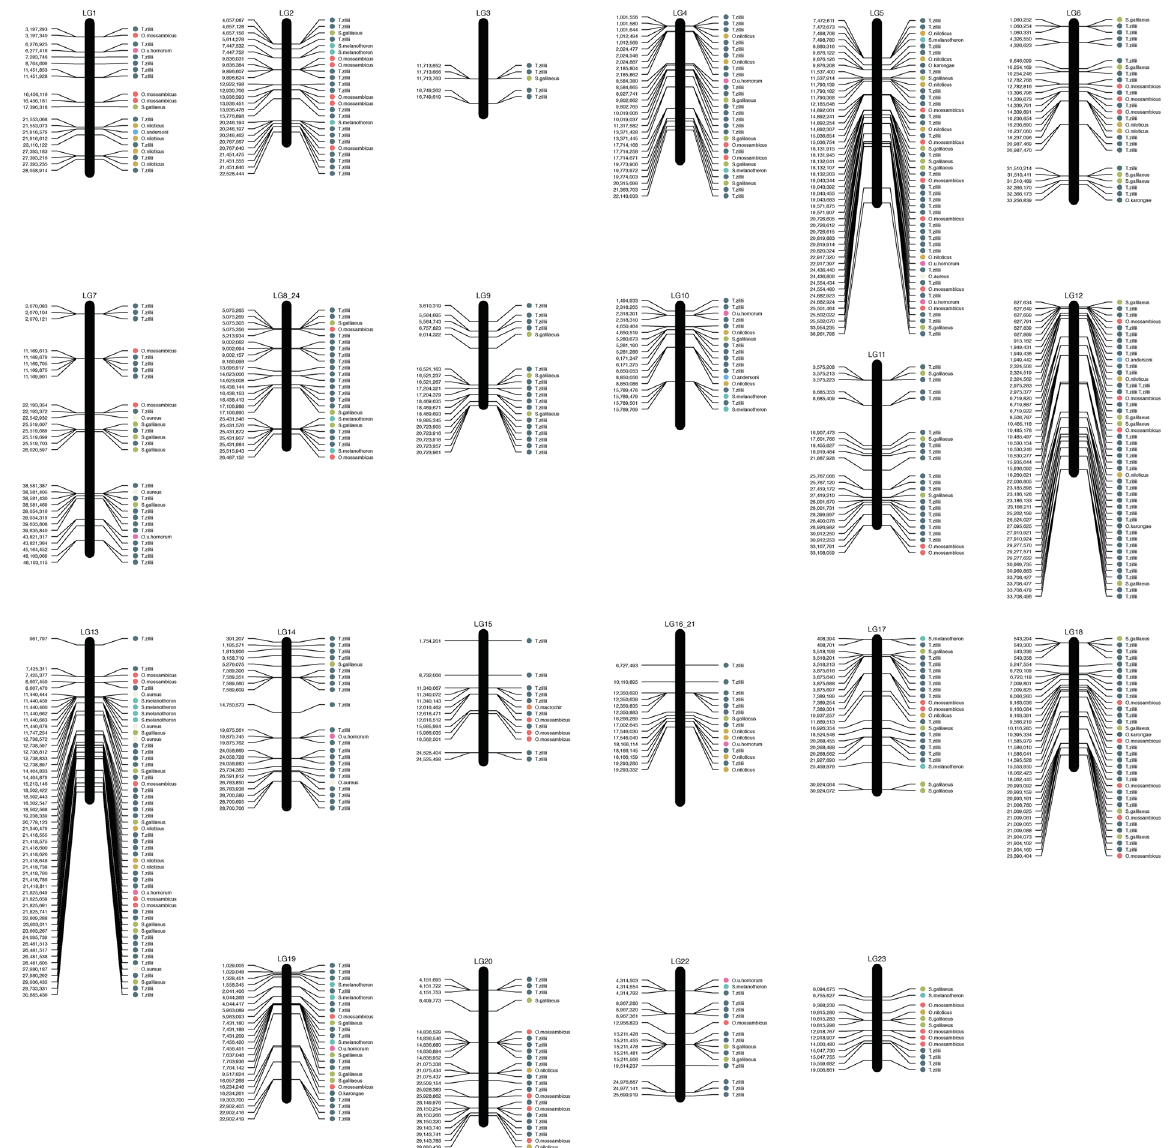
Figure 3. Physical mapping of 644 species-specific SNP markers (RBA, with up to five SNPs per ddRAD locus – see text for further details) in the reference